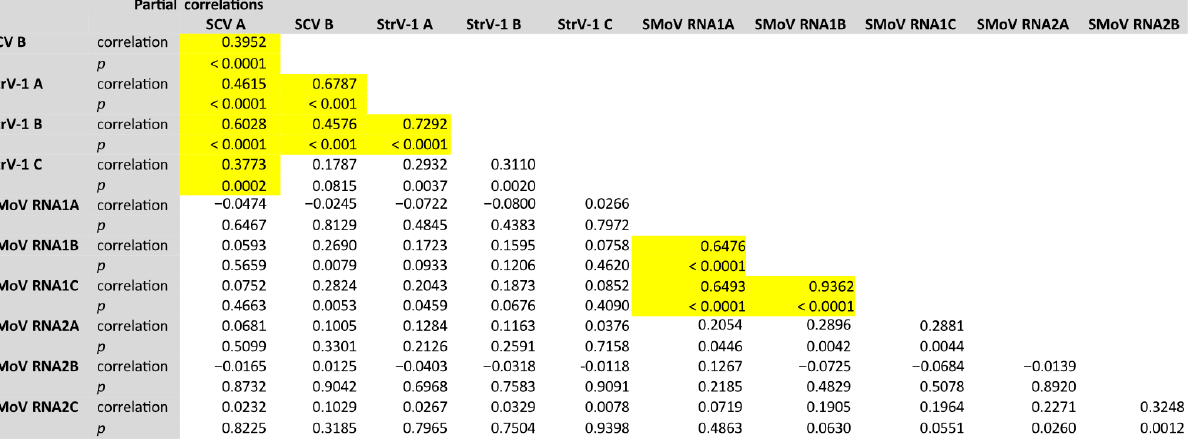
Figure 5. Pairwise partial correlations. Significant cases after applying the false discovery rate correction are highlighted in yellow. In all tests, the number of degrees of freedom was 94.